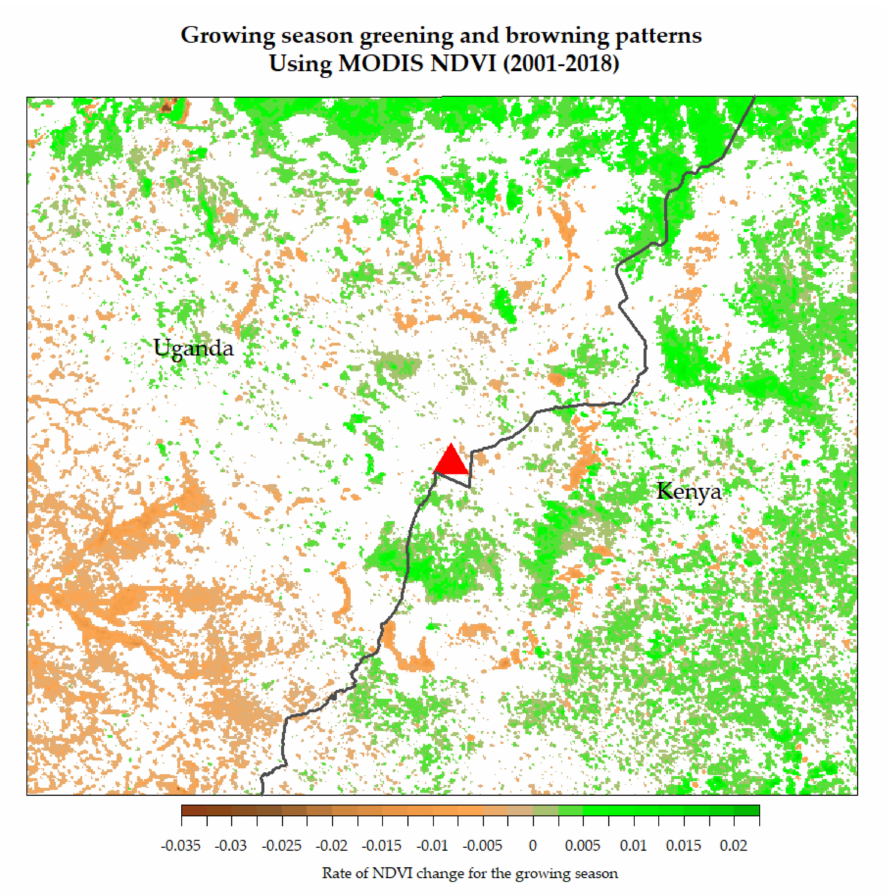
Figure 4. Map of significant changed (greened and browned) locations during the growing season. Slope values (Kendall τ ), indicative of magnitude of change per time step, are shown here. White pixels indicate no significant